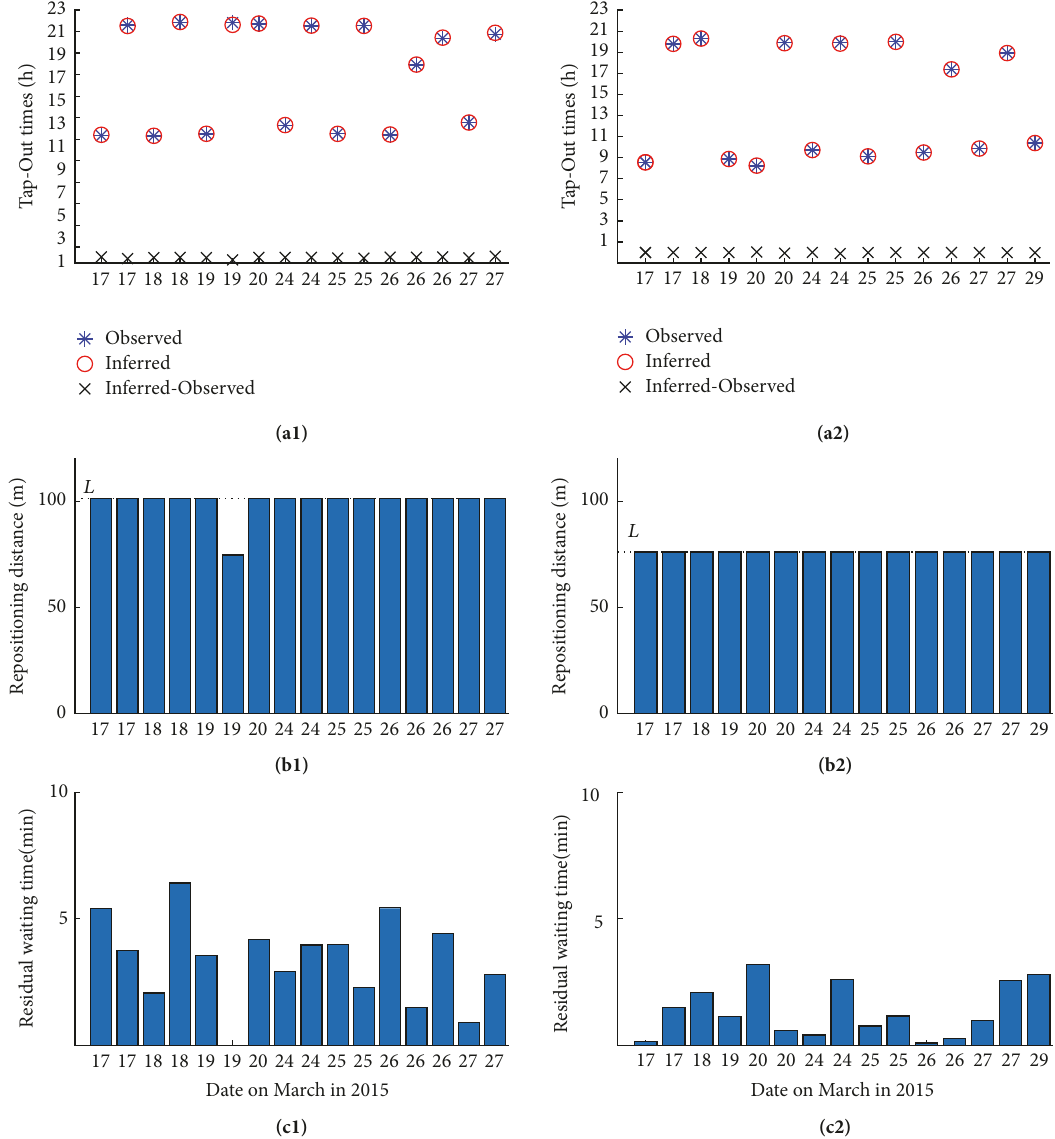
Figure 7: Inferred results about: (a) tap-out time; (b) repositioning distance; and (c) residual waiting